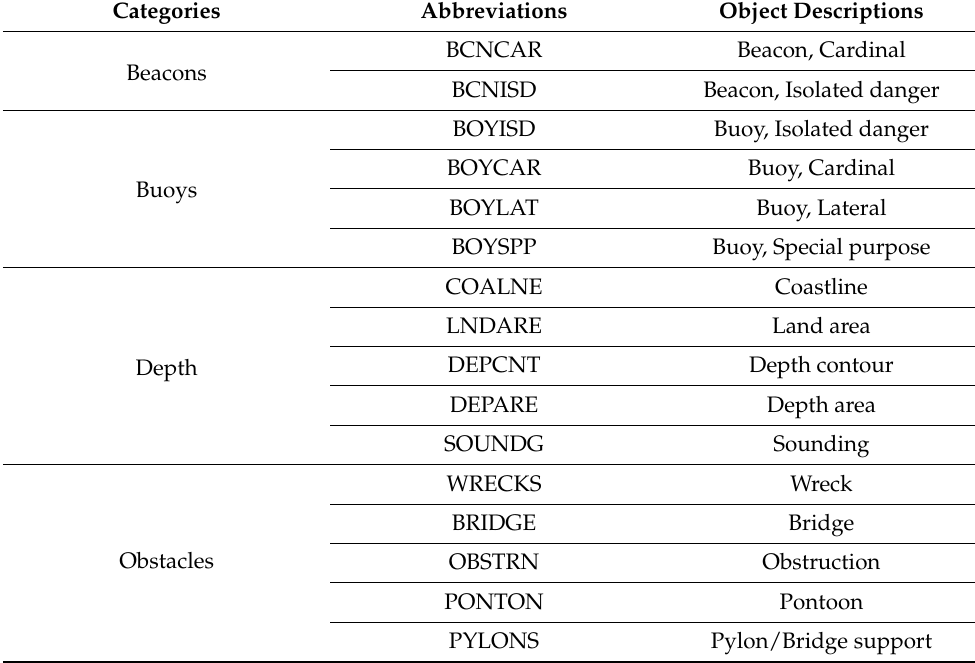
Table 3. Physical objects from ENC data.